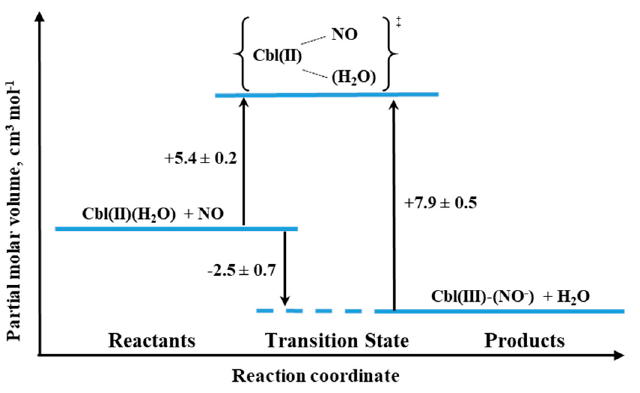
Figure 20. The volume profile for the reaction of Cbl(II) with NO in aqueous solution at pH = 7.4. One of the biologically relevant pathways for the interaction of Cbl(H 2 O) with NO involves reactions with endogenous S-nitrosothiols (RSNO). Their binding to the metal center, regardless of whether realized through a sulfur or nitrogen atom, usually leads to homolytic cleavage of the S-NO bond, which may affect nitric oxide homeostasis. This prompted an in-depth study on the mechanisms of these interactions, considering various potential reaction sequences leading to the formation and further fate of Cbl(RSNO).